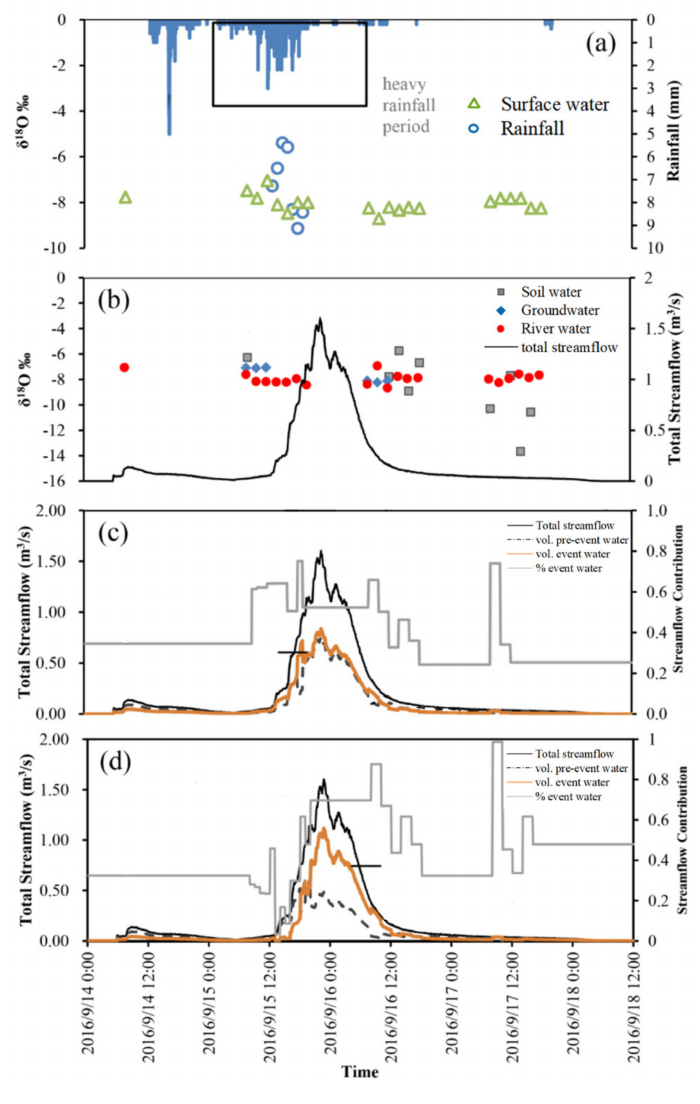
Figure 2. ( a ) Rainfall and surface water δ 18 O composition during the typhoon storm and rainfall amount. ( b ) δ 18 Ovaluesforsoilwater, groundwaterandstreamflow. ( c )Dischargeandresultsofthetwo-component mixing model, using δ 18 O for pre-event and event waters as a constant. ( d ) Discharge and results of the two-component mixing model, using temporal variation in δ 18O in